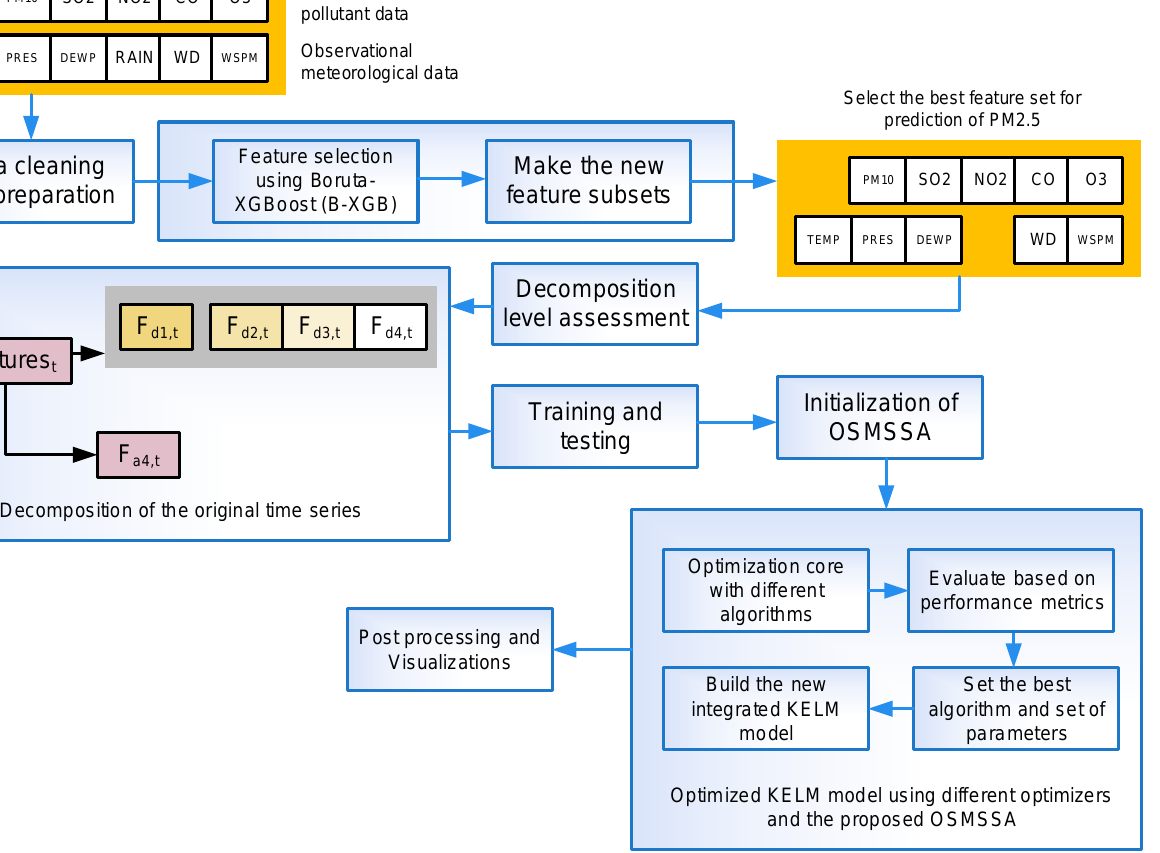
Figure 4. Flowchart of the proposed wavelet PM2.5 prediction system (WD-OSMSSAKELM) with Boruta-XGBoost feature